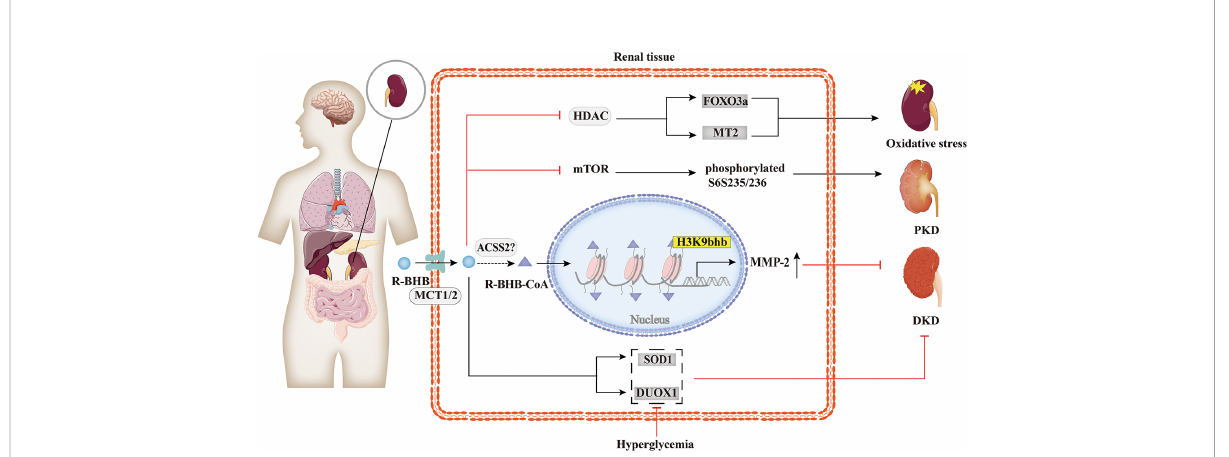
FIGURE 5 Histone Kbhb in kidney diseases. BHB has a signi fi cant protective effect against renal oxidative stress by inhibiting HDAC and enhancing FOXO3a and MT2 activity. BHB also suppressed mTOR and its downstream target, phosphorylated S6 S235/236 , markedly decreased collagen deposition and alleviated polycystic kidney disease (PKD). In addition, BHB alleviates diabetic kidney disease (DKD) by increasing the expression of SOD and DUOX1. A recent study found that BHB signi fi cantly upregulated matrix metalloproteinase-2 (MMP-2) expression by elevating H3K9bhb in the MMP-2 promoter to antagonize glomerulosclerosis in DKD